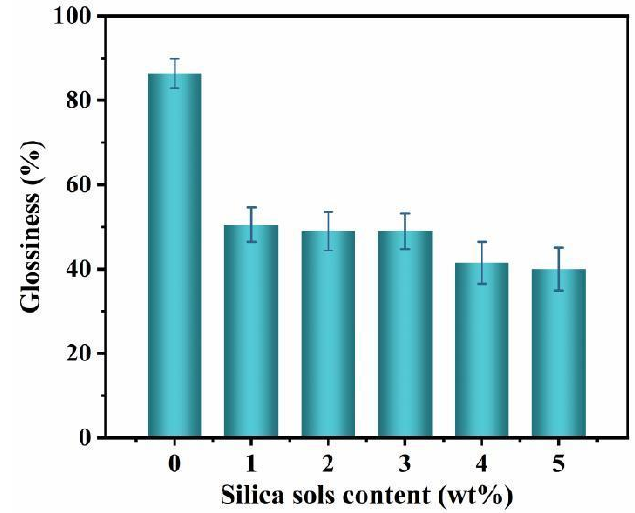
Figure 8. Effect of silica sol content on the glossiness of UV-curable WA coatings.